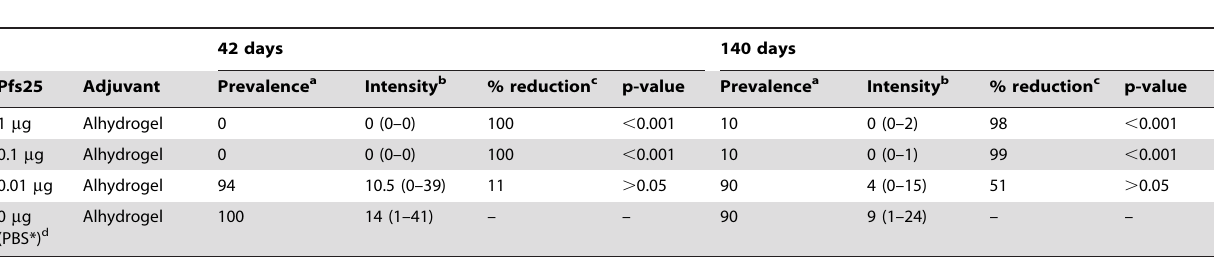
Table 2. Evaluation of TB activity in immunized mouse sera by SMFA: dose reduction